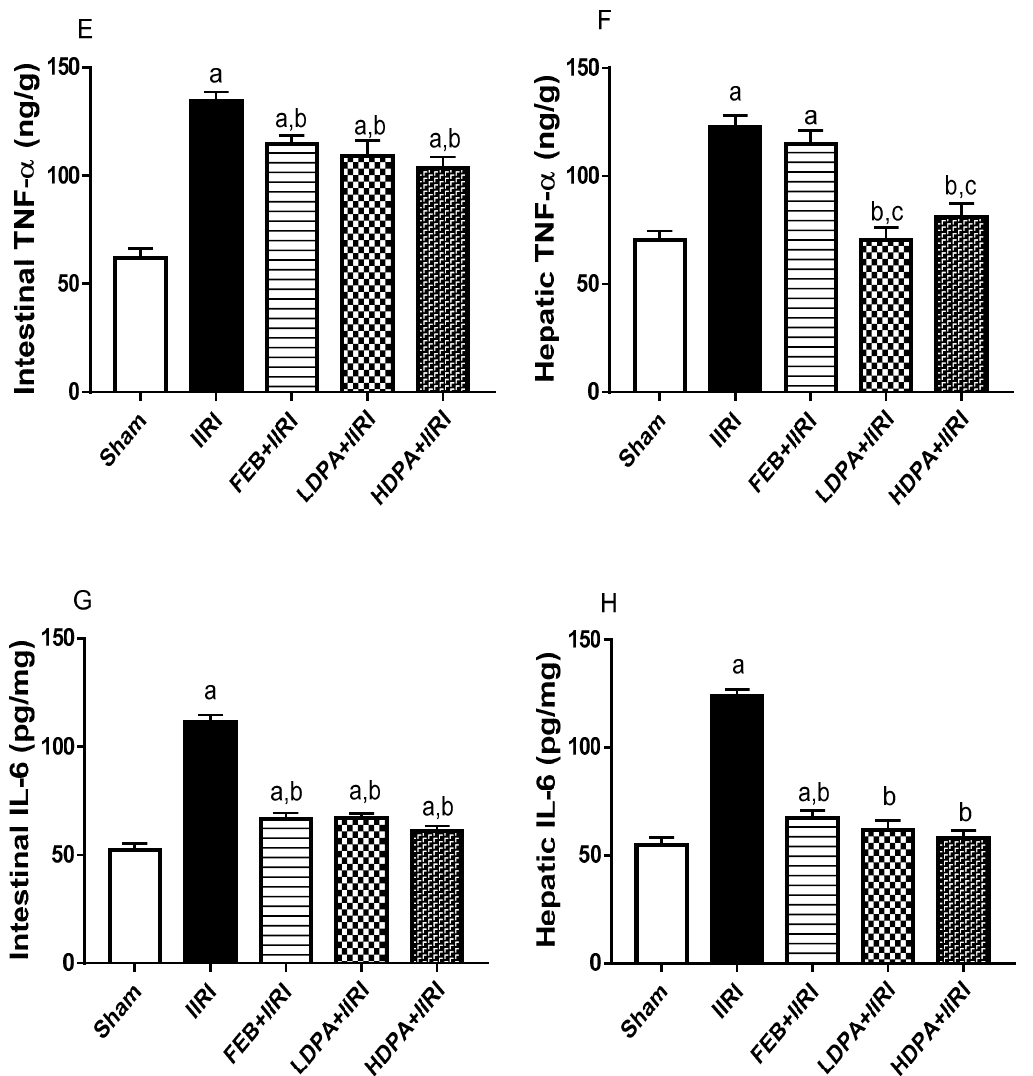
Figure 4. Effect of intestinal ischemia/reperfusion (I/R) and methanolic Phyllanthus Amarus leaf ex- tract on markers of inflammation in the intestinal and hepatic tissues. FEB, LDPA, and HDPA sig- nificantly reduced IIRI-induced increase in intestinal NO ( A ) and hepatic NO ( B ), intestinal MPO ( C ) and hepatic MPO activity ( D ), intestinal TNF- α ( E ), hepatic TNF- α ( F ), intestinal IL-6 ( G ) and hepatic IL-6 ( H ) levels. IIRI: intestinal ischemia/reperfusion injury, FEB: febuxostat, LDPA: low-dose Phyllanthus Amarus, HDPA: high-dose Phyllanthus Amarus, a p < 0.05 versus sham, b p < 0.05 versus IIRI, c p < 0.05 versus FEB + IIRI, d p < 0.05 versus LDPA + IIRI. Values represent the mean for ten replicates ± the standard deviation.